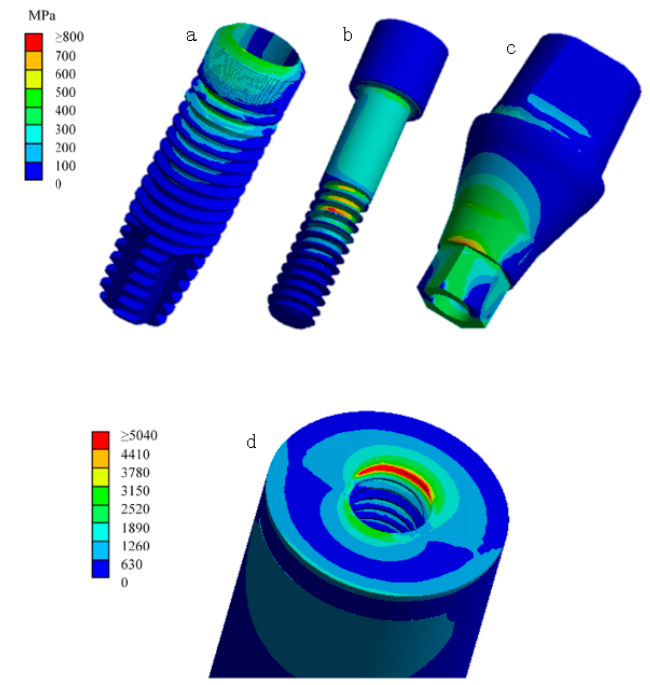
Figure 3. Stress patterns for implant stress (MPa) ( a ), abutment screw stress (MPa)( b ), abutment stress (MPa) ( c ), and bone strain (micro strain) ( d ).